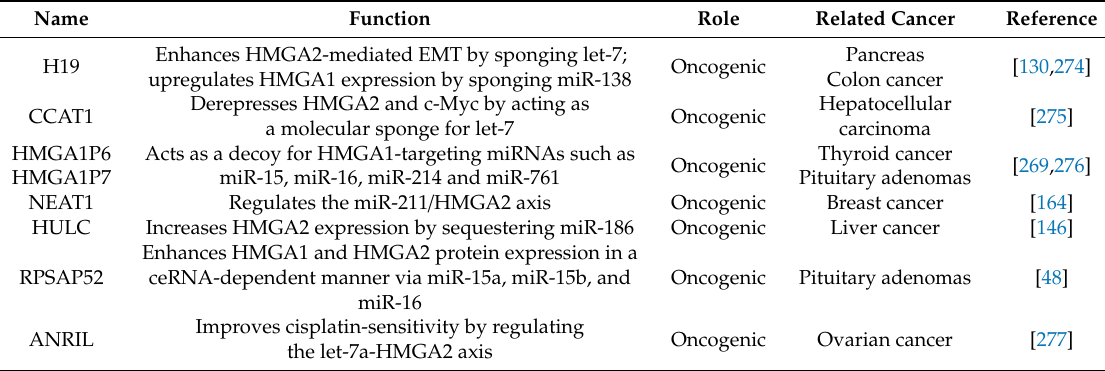
Table 2. List of lncRNAs acting as ceRNA towards HMGA-targeting